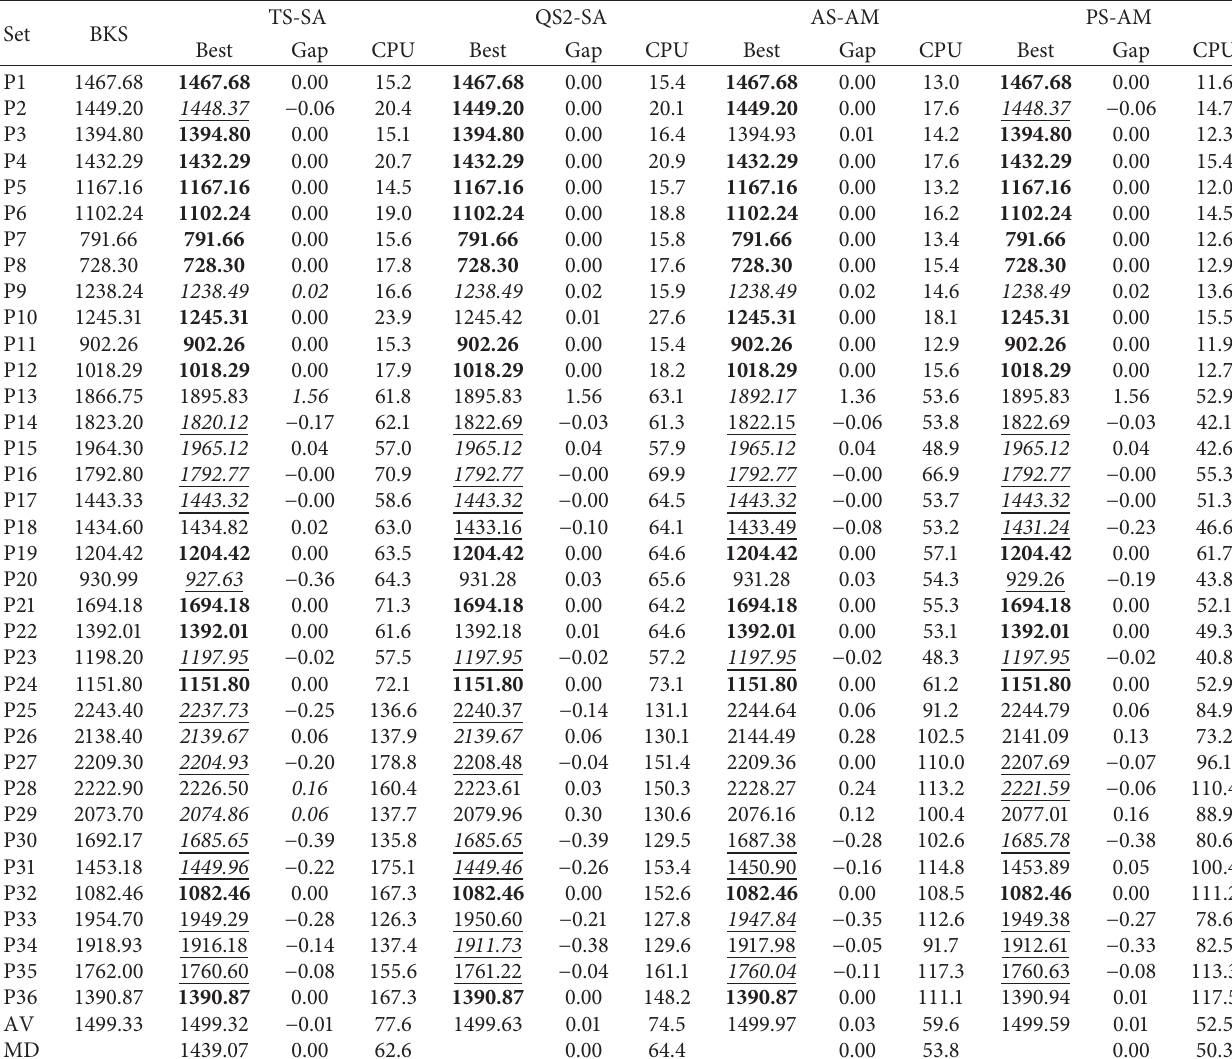
Table 6: Results for the CLRP instances in Tuzun and Burke.